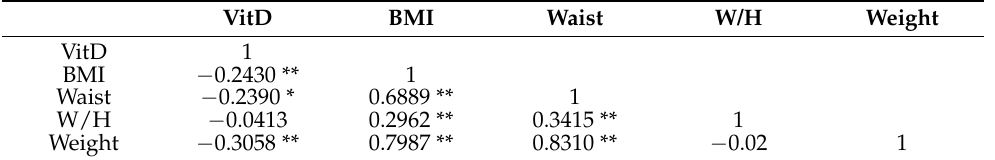
Table 2. Correlation matrix between VitD serum values and adiposity indices.